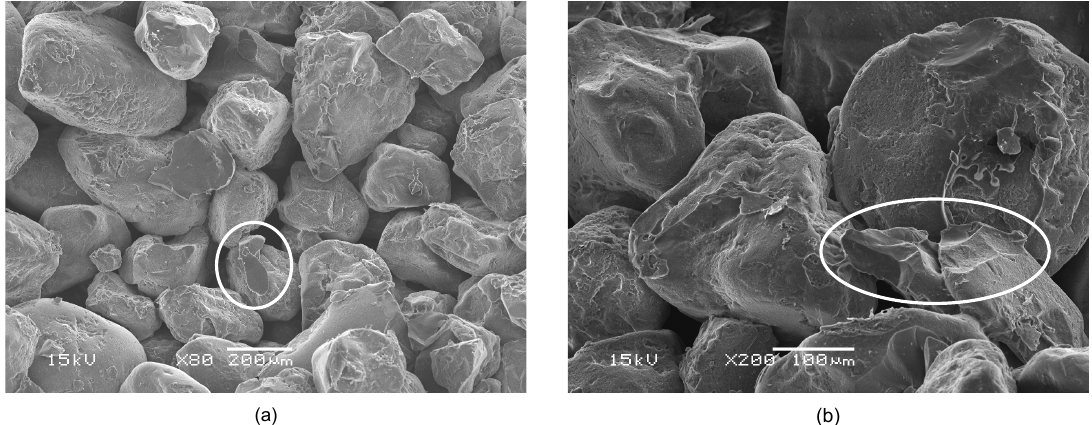
Figure 3. Overview of inorganically-bound quartz sand with broken binder bridges ( a ) and a broken binder bridge with signs of brittle failure ( b